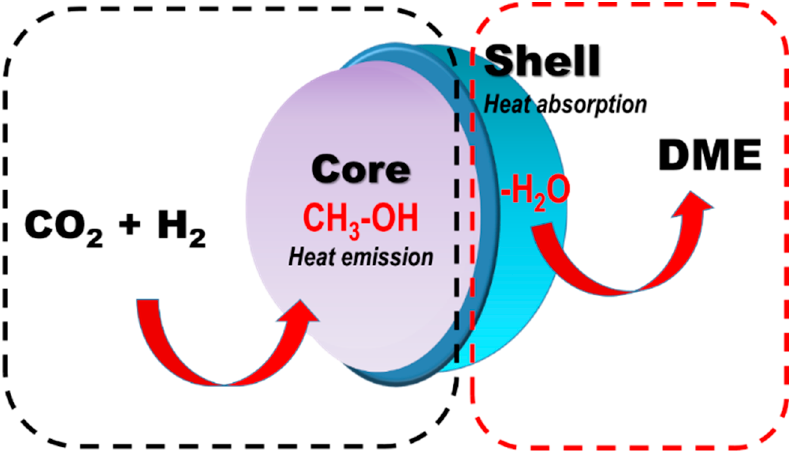
Figure 15. Illustration of direct CO 2 hydrogenation on a bifunctional capsule catalyst.